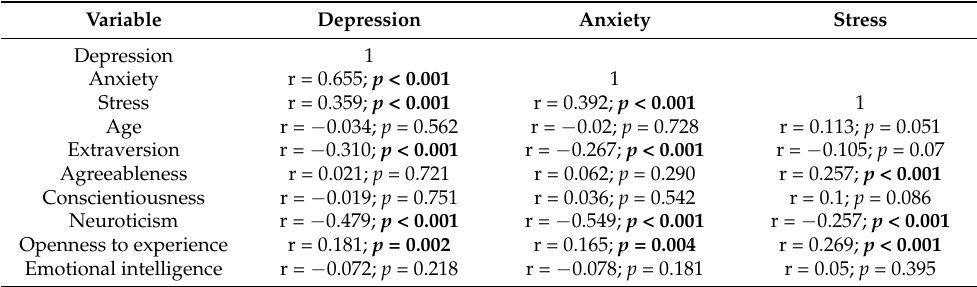
Table 3. Bivariate analysis of continuous variables associated with the mental health scores. Variable